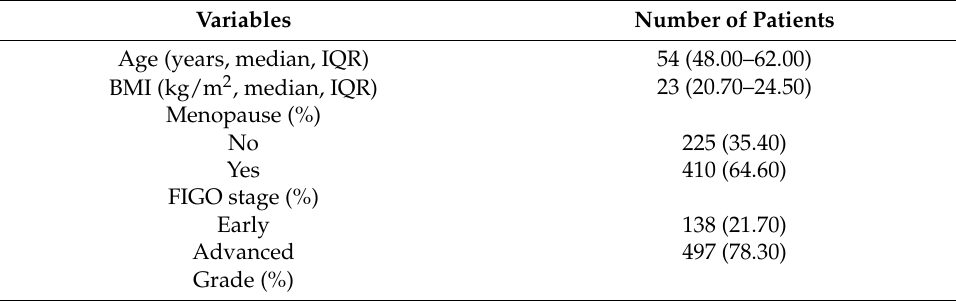
Table 1. Baseline patient characteristics ( n =